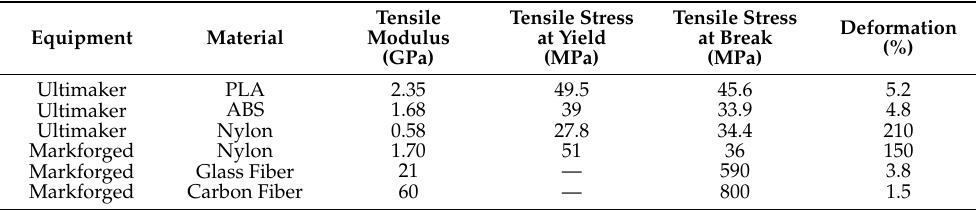
Table 1. Mechanical tensile properties of materials (data from supplier, carbon and glass fiber tests (ASTM)